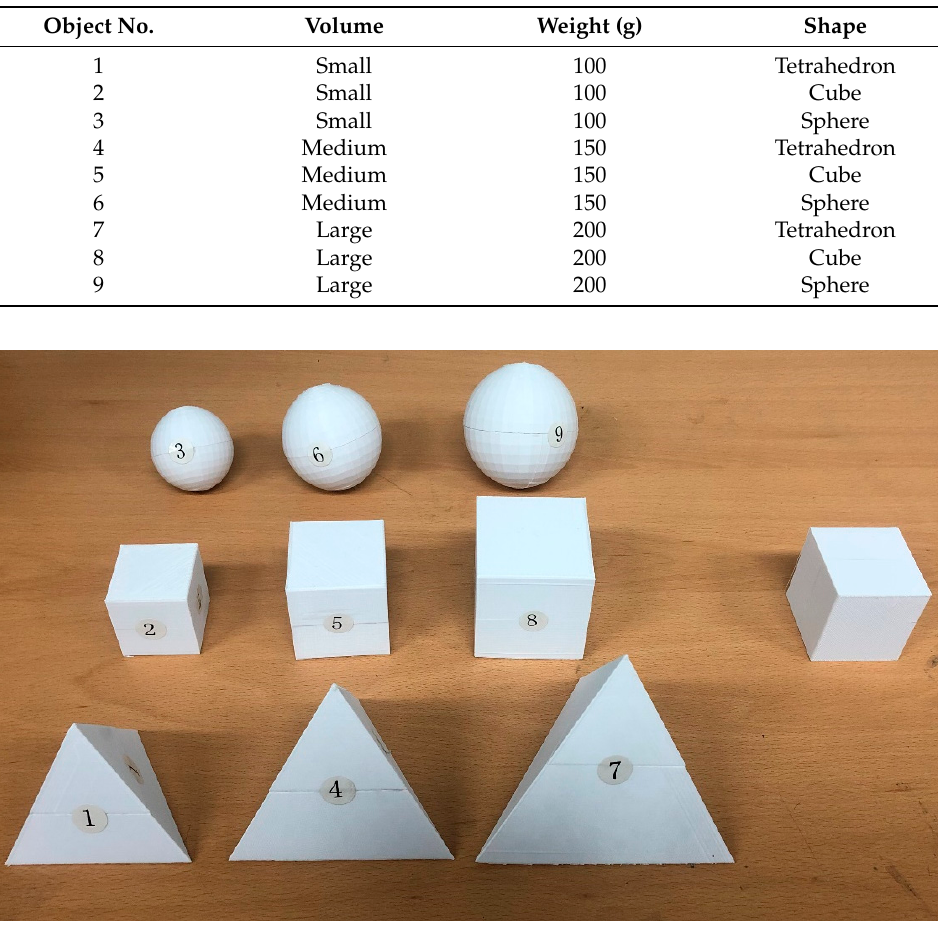
Figure 1. Nine objects and one reference object in the experiment (the reference object is the same as object